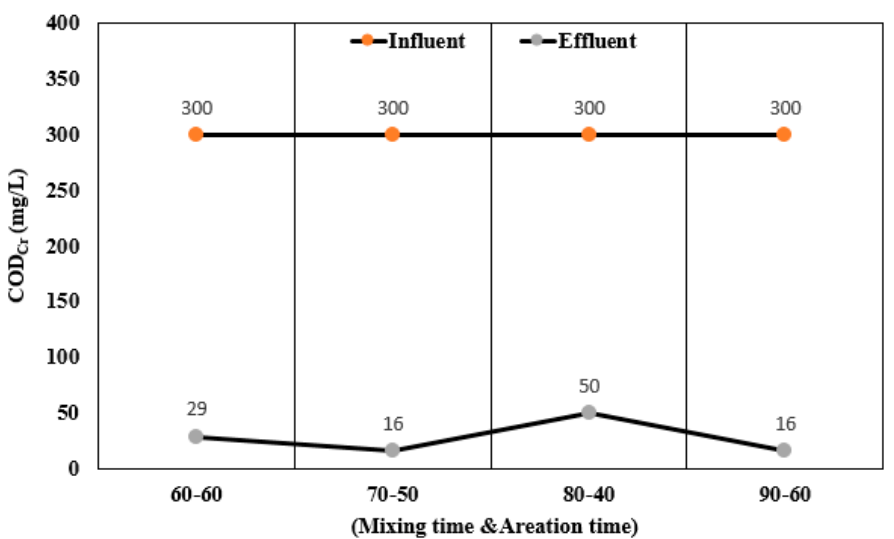
Figure 4. Schematic figure of the bench-scale shipboard STP.